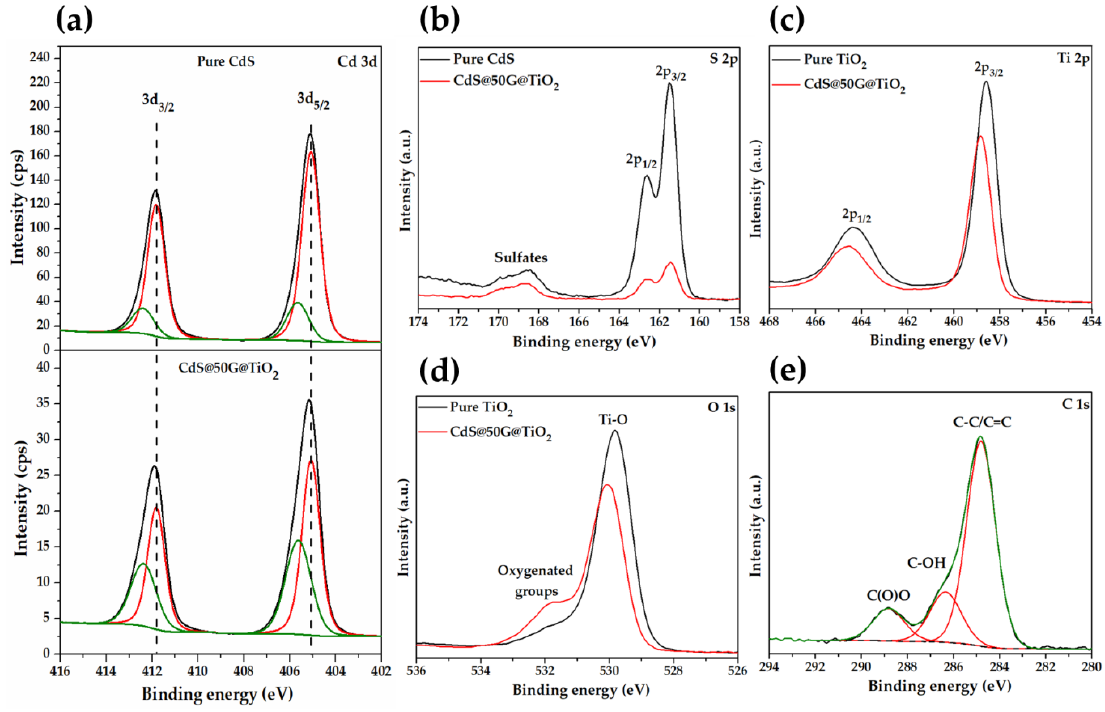
Figure 4. High resolution XPS analysis of Cd 3d in pure CdS and CdS@50G@TiO 2 ( a ), S 2p ( b ), Ti 2p ( c ), O 1s ( d ) of pure CdS and CdS@50G@TiO 2 and C 1s of CdS@50G@TiO 2 ( e ).